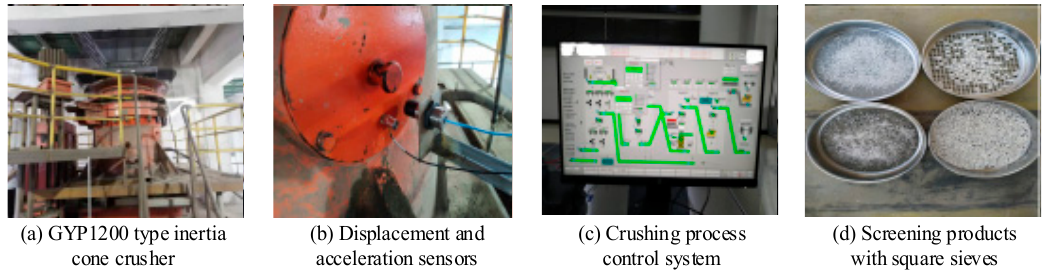
Figure 15. The GYP1200 type crusher test devices.